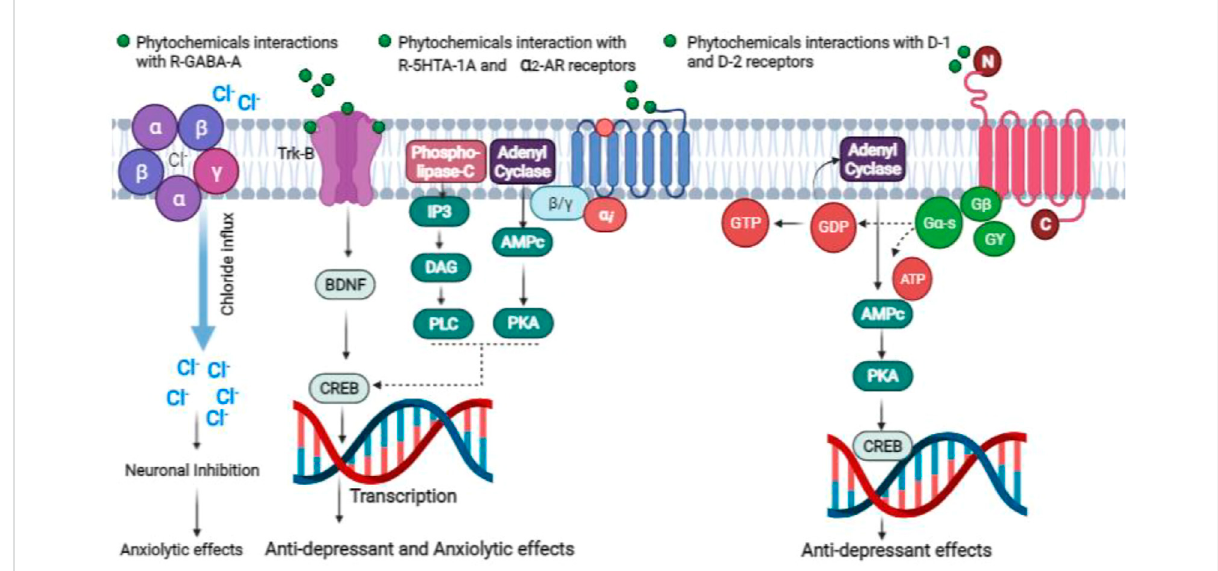
FIGURE 4 Mechanisms underlying the anti-depressant and anxiolytic effects of